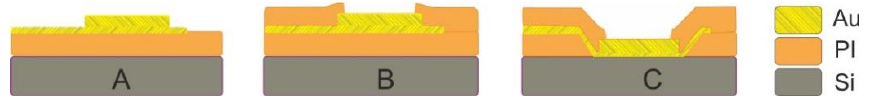
Figure 11. Specimen types used in adhesion ( A – C ) and electrical ( B , C ) tests.